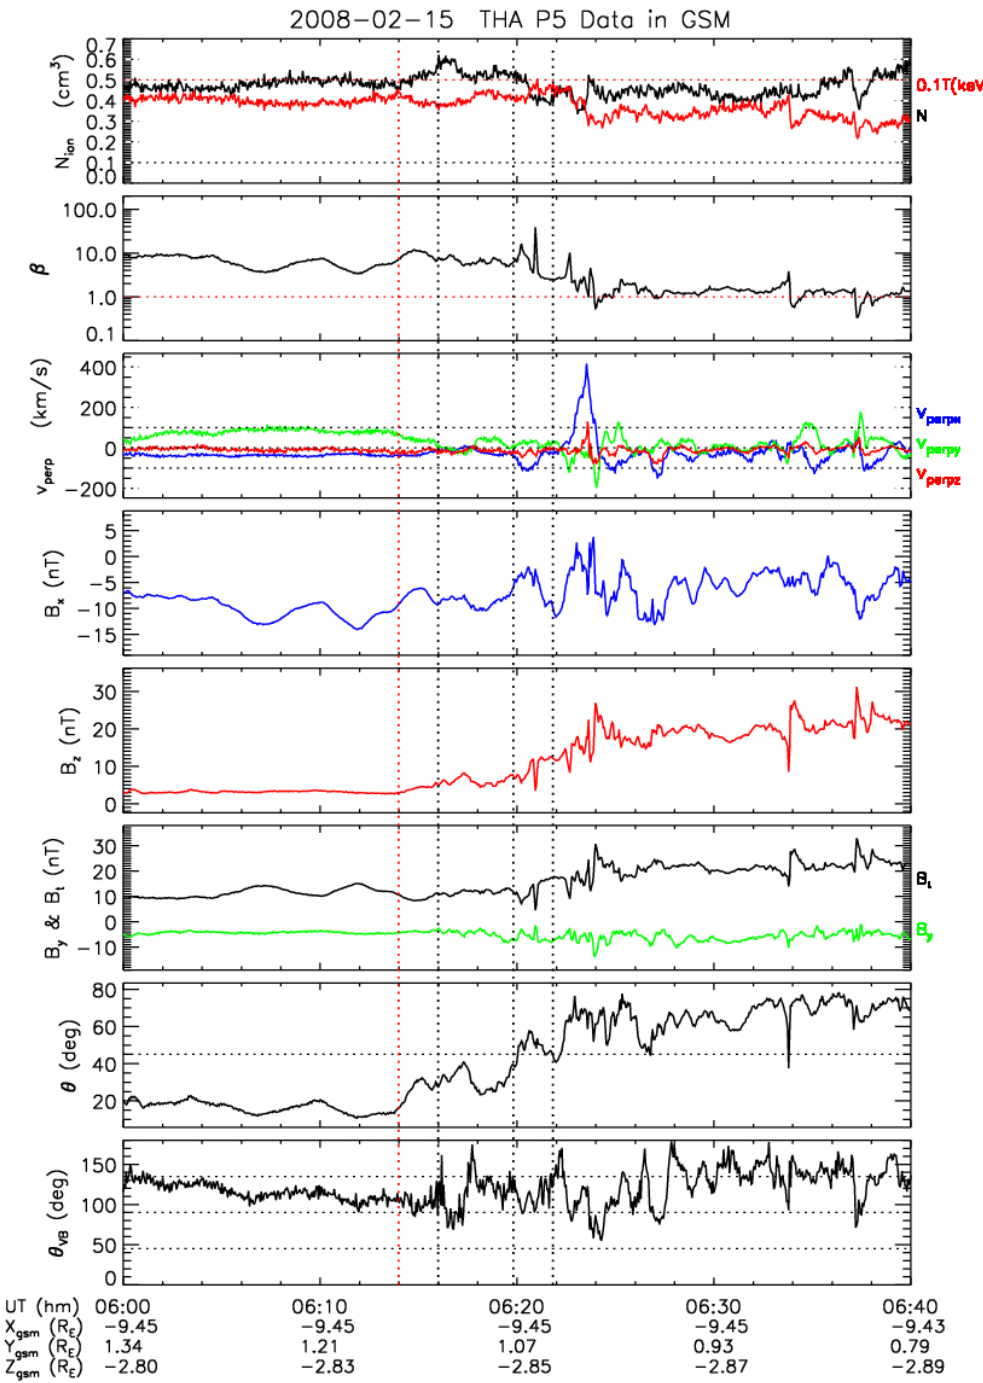
Fig. 3. THEMIS multiple probes observed the substorm occurred at 06:14UT on 15 February 2008 in the near-Earth plasma sheet. Panels (a) , (b) and (c) are from THA, THE and THD, respectively. The format of these three figures are the same, from top to bottom are hot ion density, N , (black line) and temperature T (red line 0.1 T ion ) , the plasma beta, β , three perpendicular components of ion bulk flow v perpx (blue line), v perpy (green line) and v perpz (red line), B x , B z , B t (black line) and B y (green line), the magnetic elevation angle θ = tan − 1 ( B z /( B 2 x + B 2 y ) 1 / 2 ) , the angle between the magnetic field and the ion bulk flow θ Bv